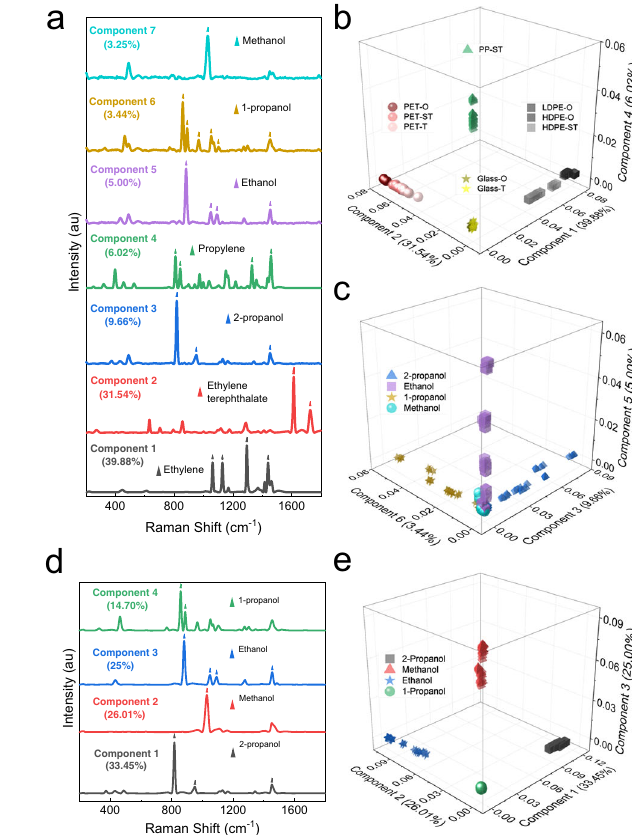
Fig. 3 Statistical comparison of SORS and traditional Raman using multivariate curve resolution. MCR scores and components of traditional ( a – c ) and scaled-subtracted ( d , e ) spectra of 2-propanol, 1-propanol, ethanol, or methanol-based hand sanitizers in various types of